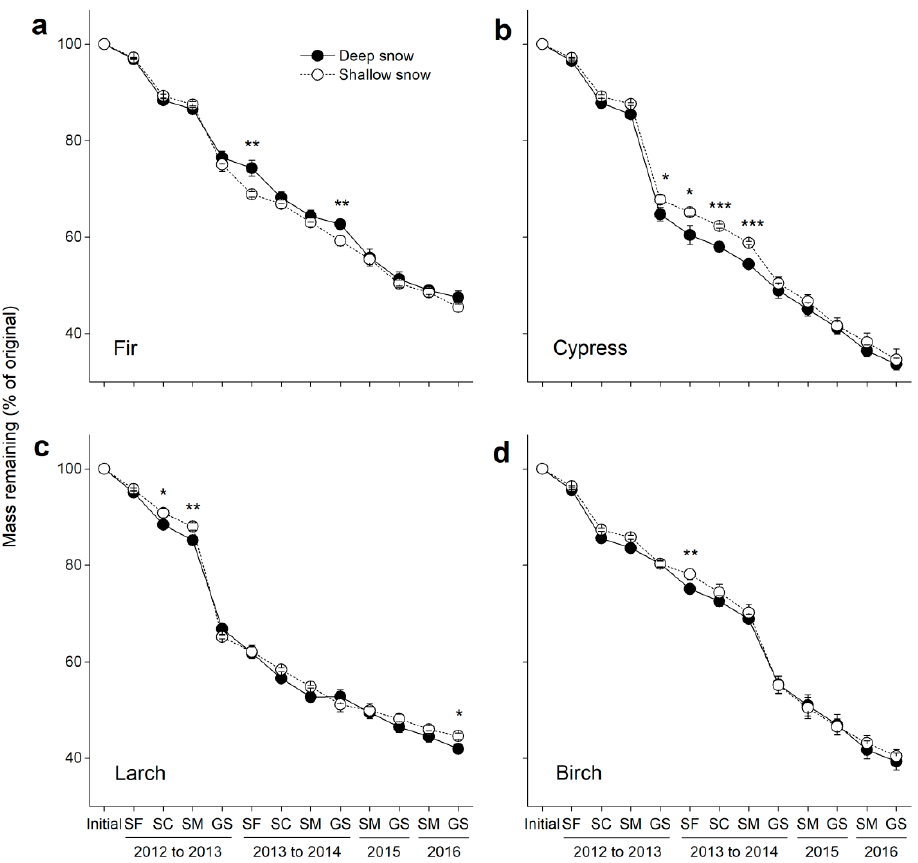
Bold p values are significant ( p < 0.05). AHC: acid hydrolysable components.